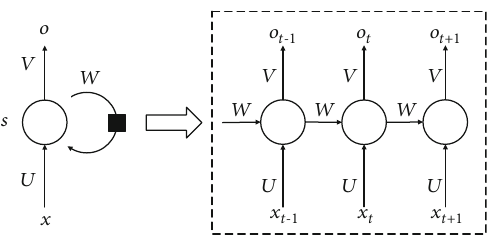
Figure 1: Schematic diagram of the recurrent neural Figure 2.